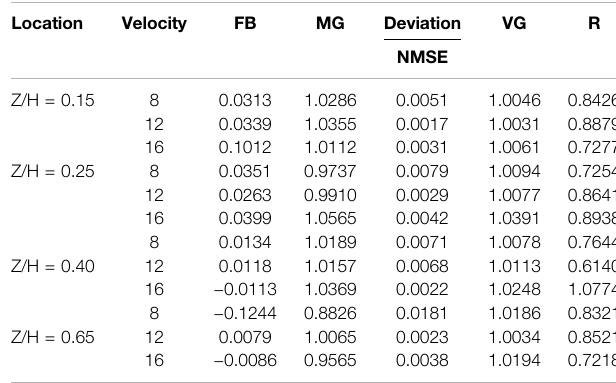
TABLE 4 | Numerical simulation results and wind tunnel test error analysis